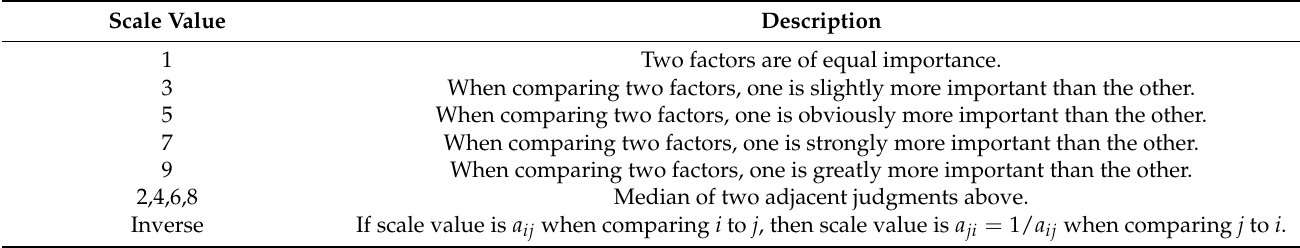
Table 2. Matrix to judge scale meaning.